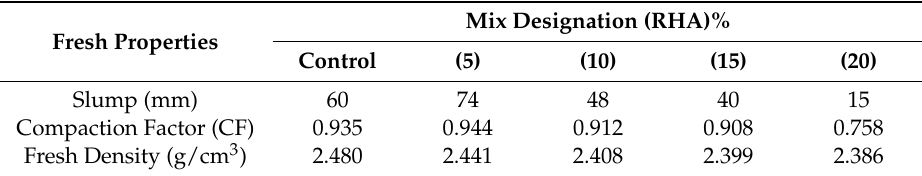
Table 6. Fresh properties of RHA concrete mixes.